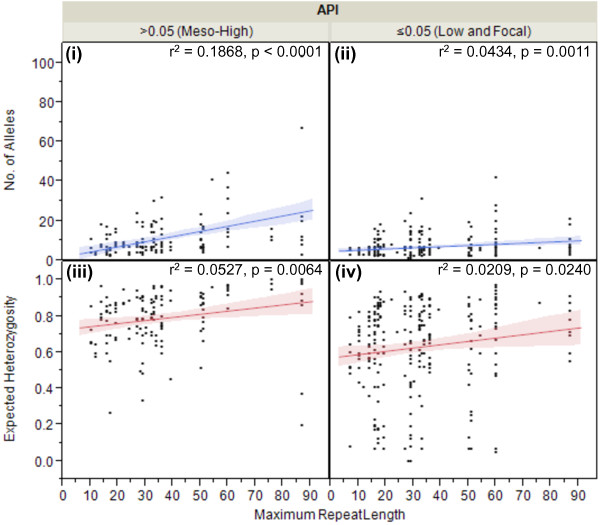
Repeat length as a function of MS diversity. For all MS markers combined, the box plots compare the mean number (no) of alleles per locus (y-axis, blue) and expected heterozygosity (He) (y-axis, red) across repeat length (x1°-axis), stratified API (x2°-axis). In both API strata, API ≤0.05 (panels ii, iv) and API >0.05 (panels i, iii), the mean no of alleles per locus (p = 0.0011 and p = 0.0240, ANOVA, bivariate fit, respectively) and mean He (p <0.0001 and p = 0.0064, ANOVA, bivariate fit, respectively) were positively correlated with the repeat length.